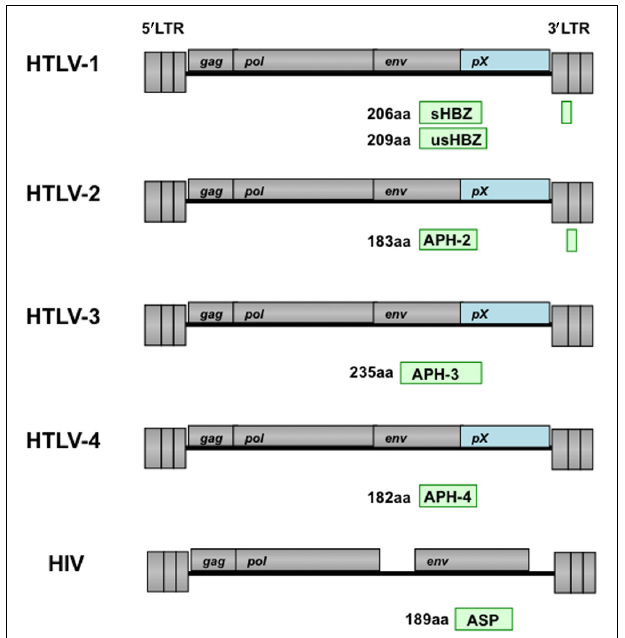
FIGURE 3 | Schematic representation of antisense transcripts in HTLV and HIV proviral genomes. Position of antisense transcript encoded proteins (APH-2/3/4) in HTLV-2, HTLV-3, and HTLV-4 is similar as HBZ in HTLV-1.The antisense protein (ASP) encoded by the minus strand of HIV genome is indicated.The number indicated the total amino acids of each protein.